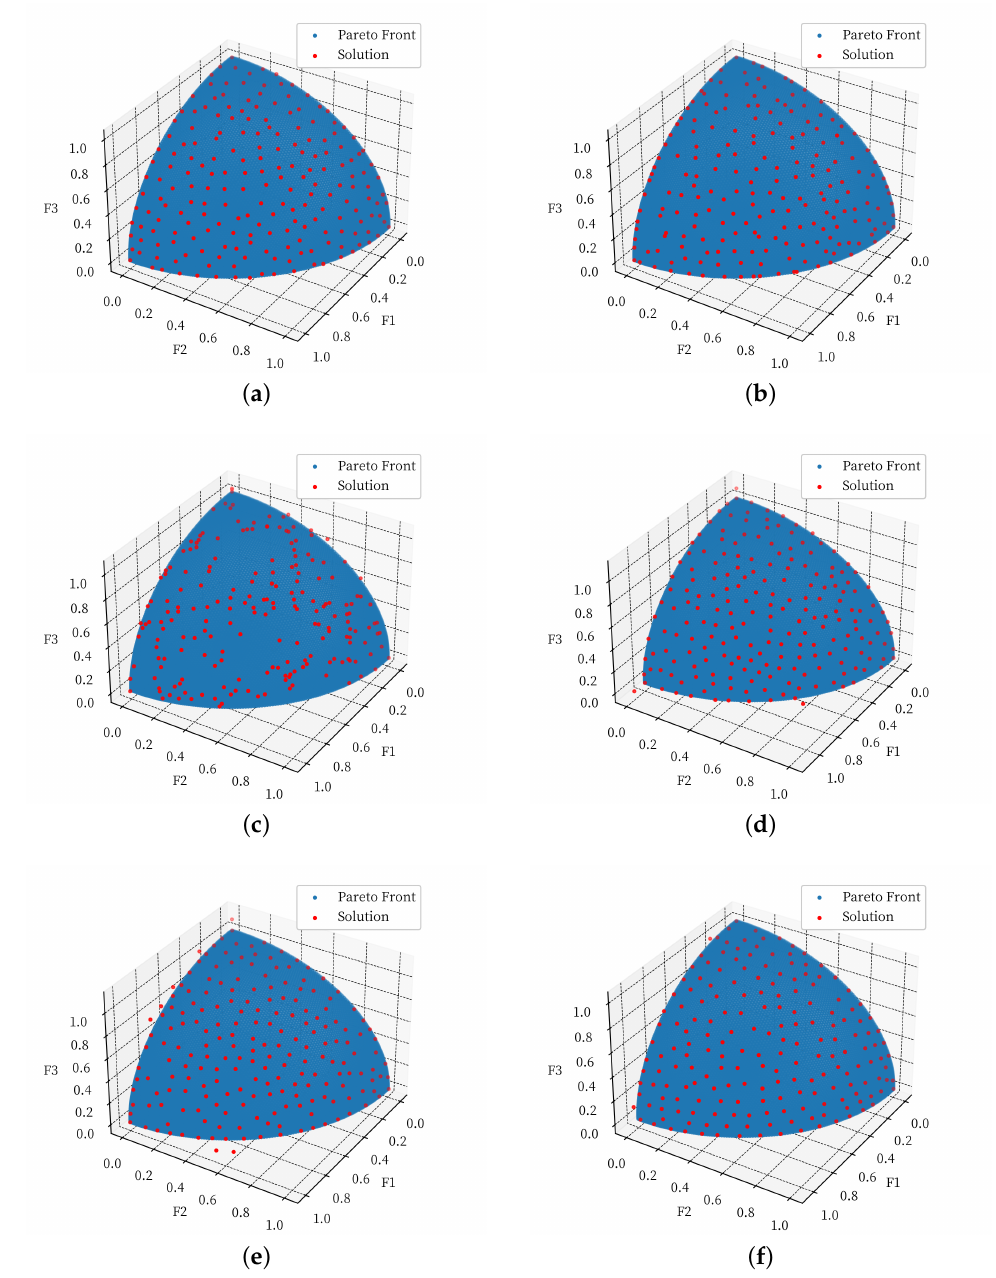
Figure 7. Comparison Between the Pareto Front and the Final Population Solution Set Obtained by the Six Different Algorithms on the DTLZ4 Test Problem Set. Subfigures ( a ) AGEMOEA, correspond to the running results of algorithms AGEMOEA, MOEA/D-URAW, NSGA-II-SDR, CMOPSO, MOEA/D-DAE, and MOEA/D-DPAW,